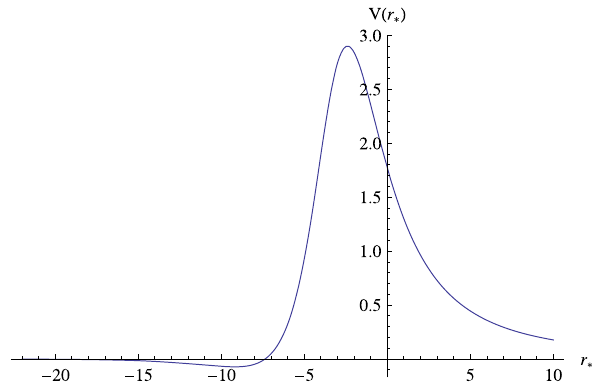
Fig. 4 The effective potnetial for vector type of gravitational pertur- bations (cid:11) = 5, α = 0 . 45, M = 1 / 2